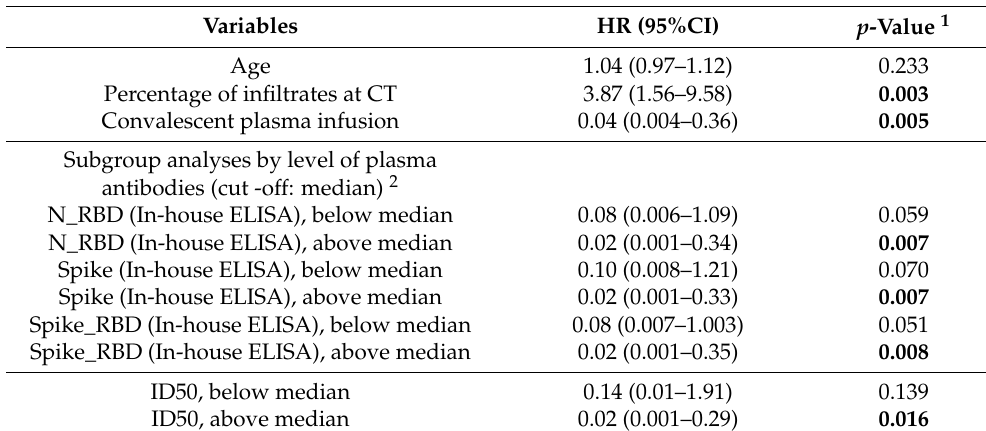
Figure 1. Kaplan-Meier Survival analysis of the recipients and controls. Table 4. Results of multivariate Cox regression analysis for the association between the convalescent plasma infusion and the antibody levels in the infused plasma and overall